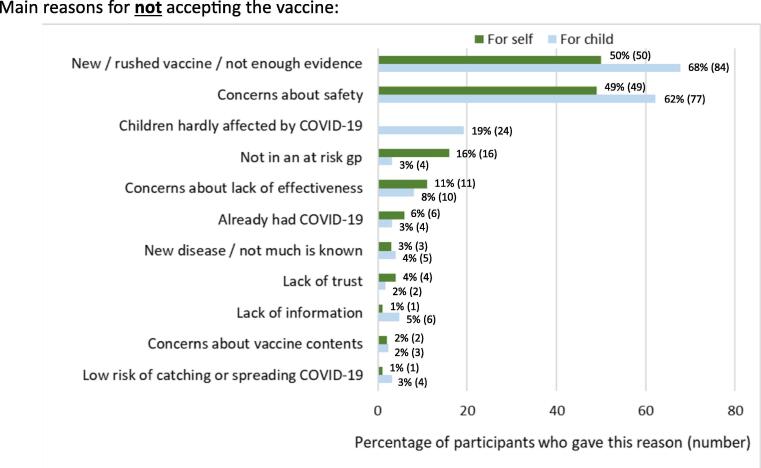
Main reasons for not accepting the vaccine.